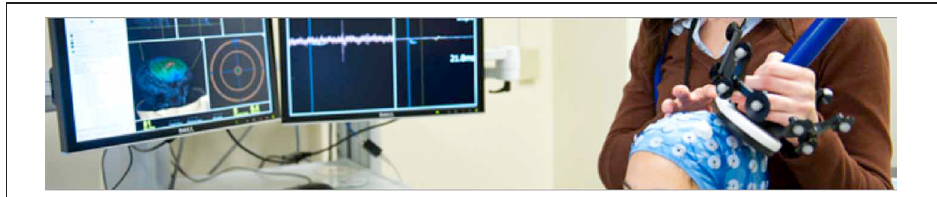
FIGURE 4 | Illustration of multimodal, neuronavigated